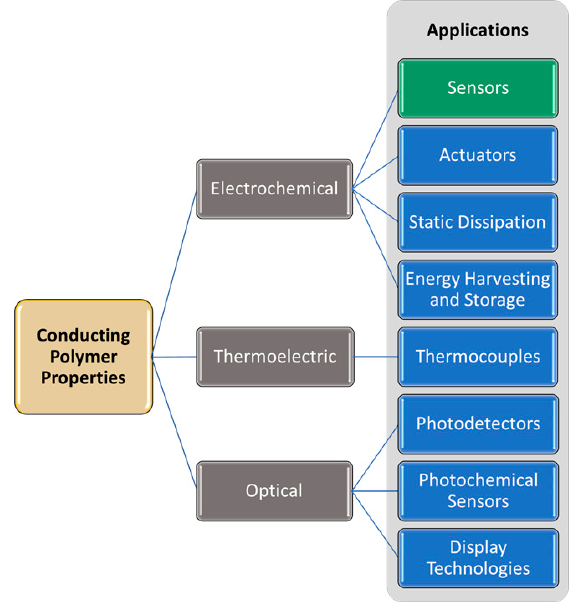
Figure 3. Conducting polymer properties with corresponding applications; the focus of this review is CP-based sensors, highlighted in green.